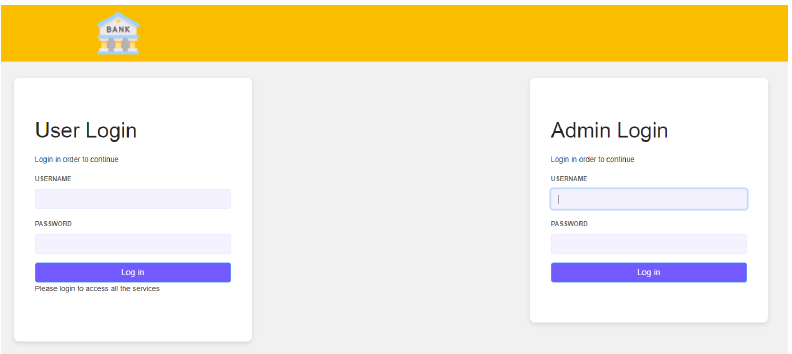
Figure 6. Bank portal for client and admin.